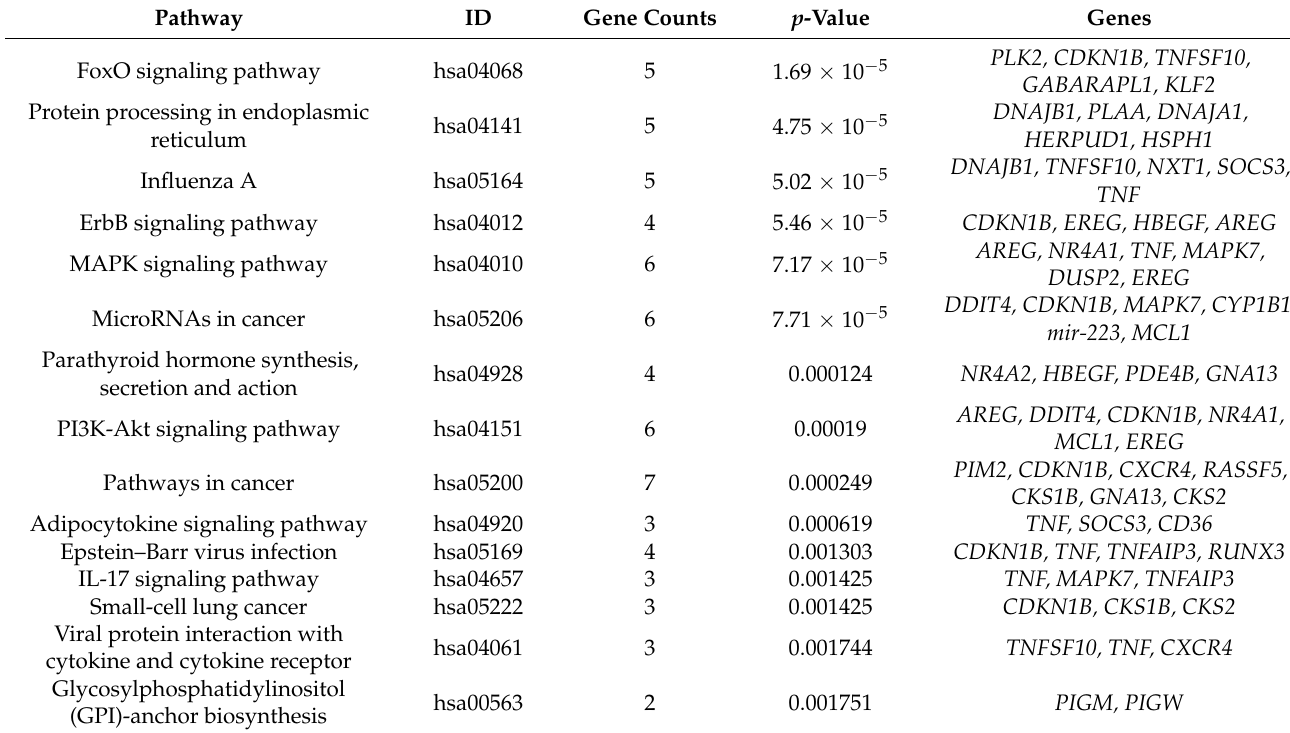
Table 2. Kyoto Encyclopedia of Genes and Genomes (KEGG) pathway analysis of